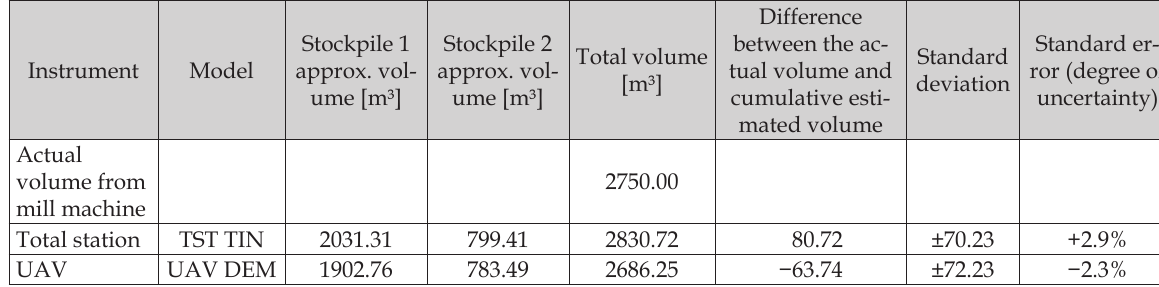
Table 4. Results of the comparative analysis of the volumes obtained from the TST-produced TIN and the UAV-produced DEM.